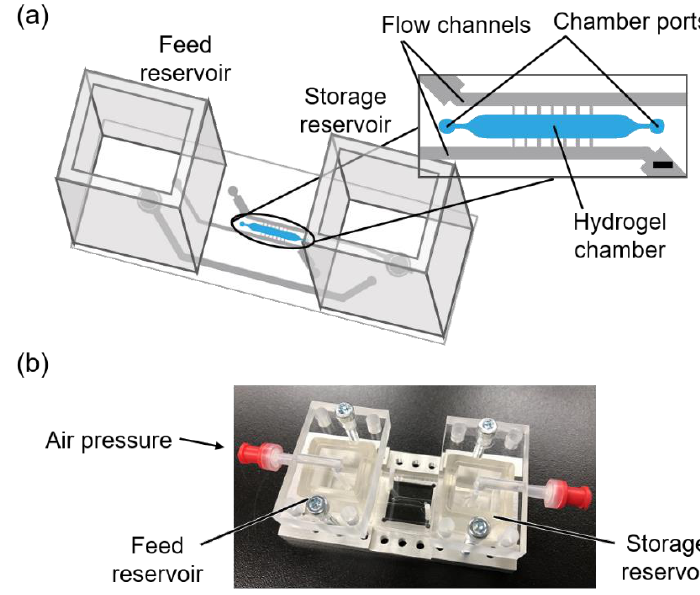
Figure 1. Schematic of the microfluidic device ( a ) and photograph of the fabricated microfluidic device ( b ). Scale bar: 1 mm ( a ).